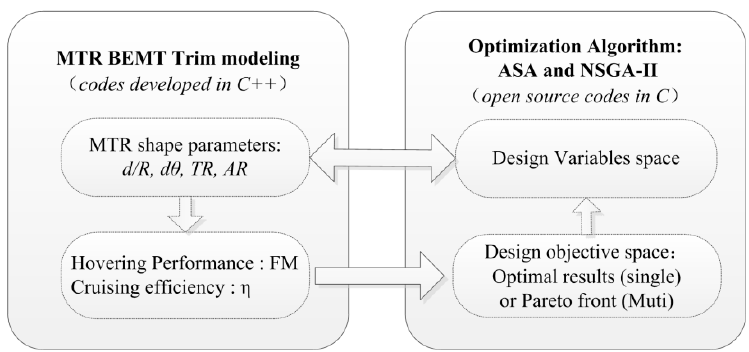
Figure 9. Two main modules of MTR optimization system. FM: figure of merit.